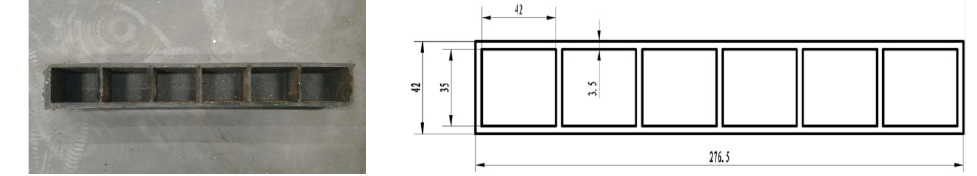
Figure 3. Specific structure and overall size of seedling trays.